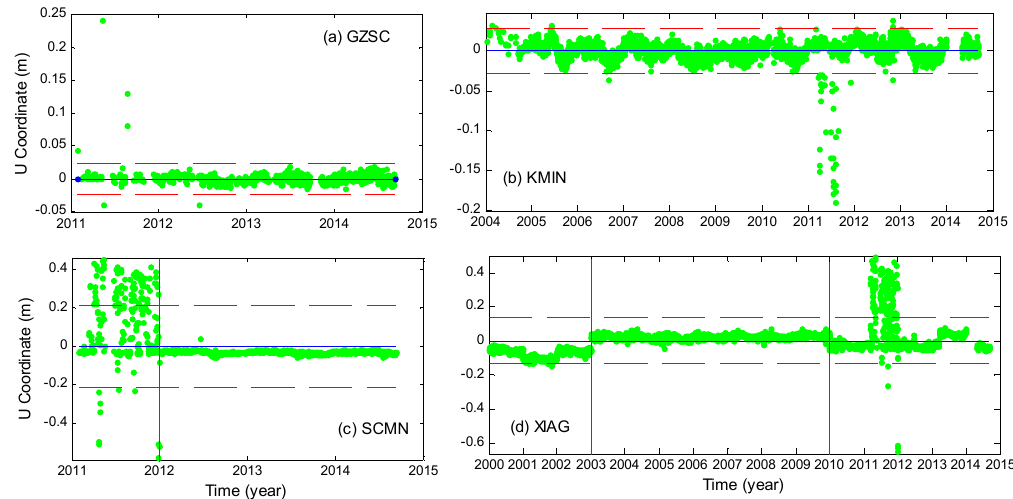
Figure 1. ( a – d ) Daily values of vertical relative positions (with linear term removal) at four typical stations, with the mean position (blue solid lines), 2 σ range (red dash lines), and the abrupt changes (red solid lines) when jumps are presented.